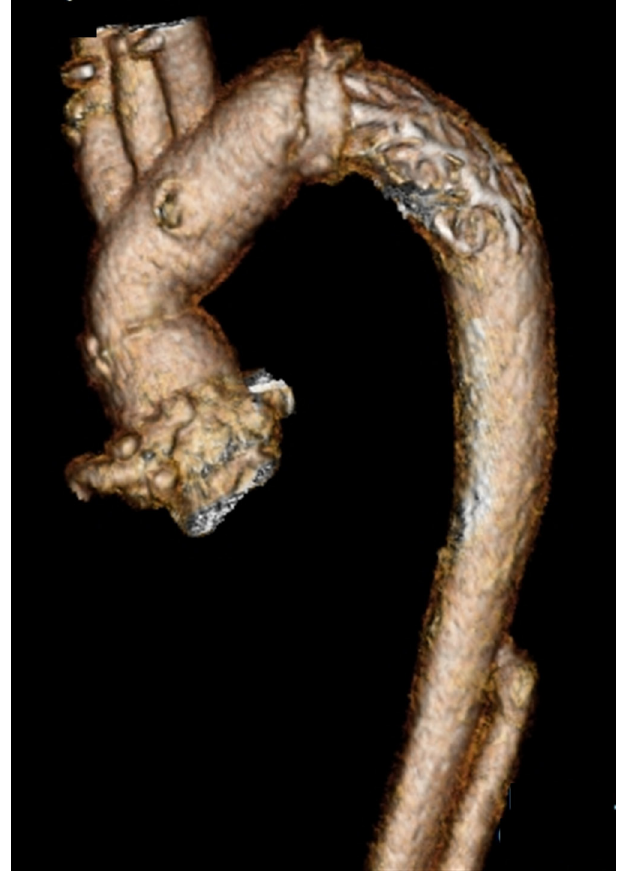
Fig. 2 – Postoperative computed tomography image Repair of the dissected aorta is shown with an artificial vascular graft.